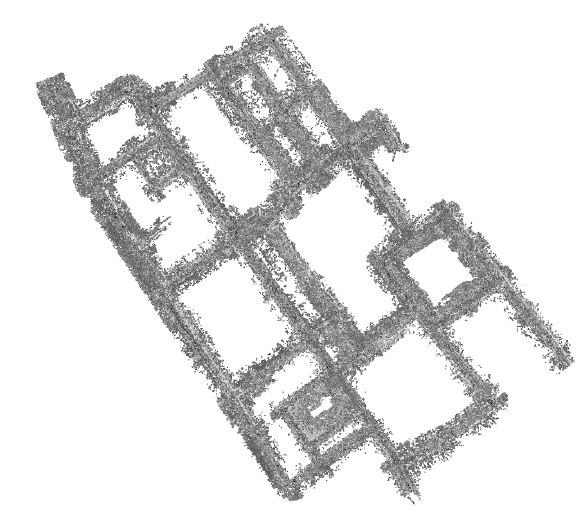
Figure 5: Overview of the medium size data set used in the experiment.